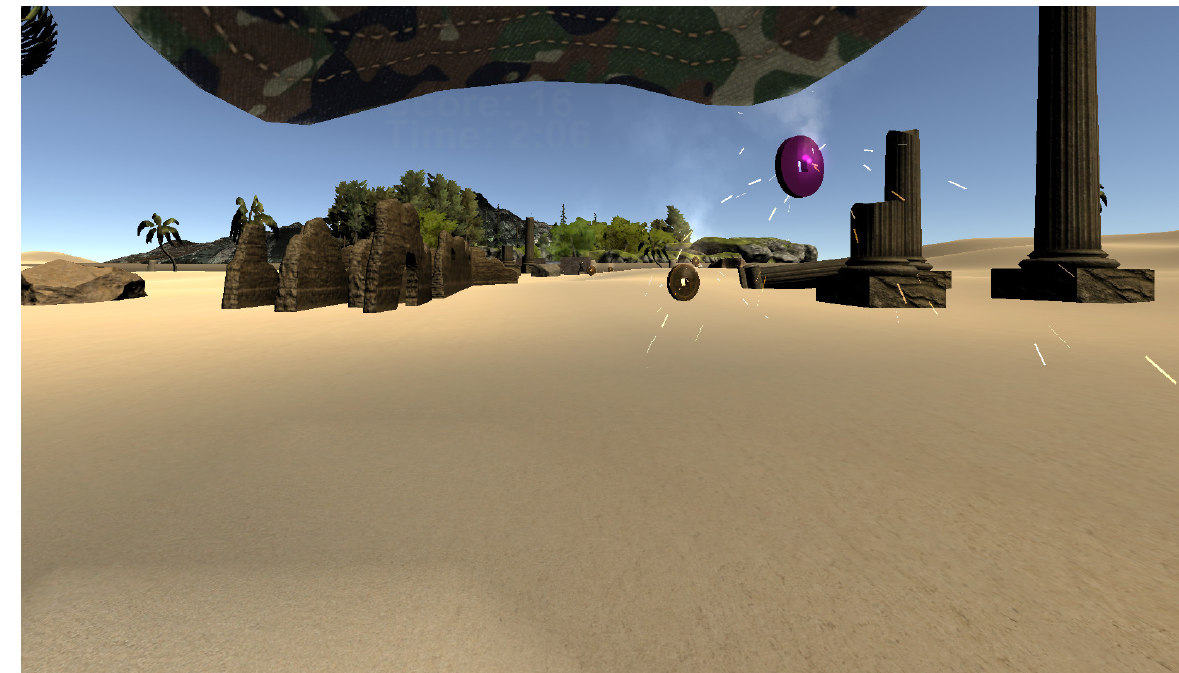
Figure 3. A desert scene from the high action game mode with a baseball hat as a head-centric rest-frame. On the figure, there is a visible violet coin. To collect the violet coin, the players needed to jump.